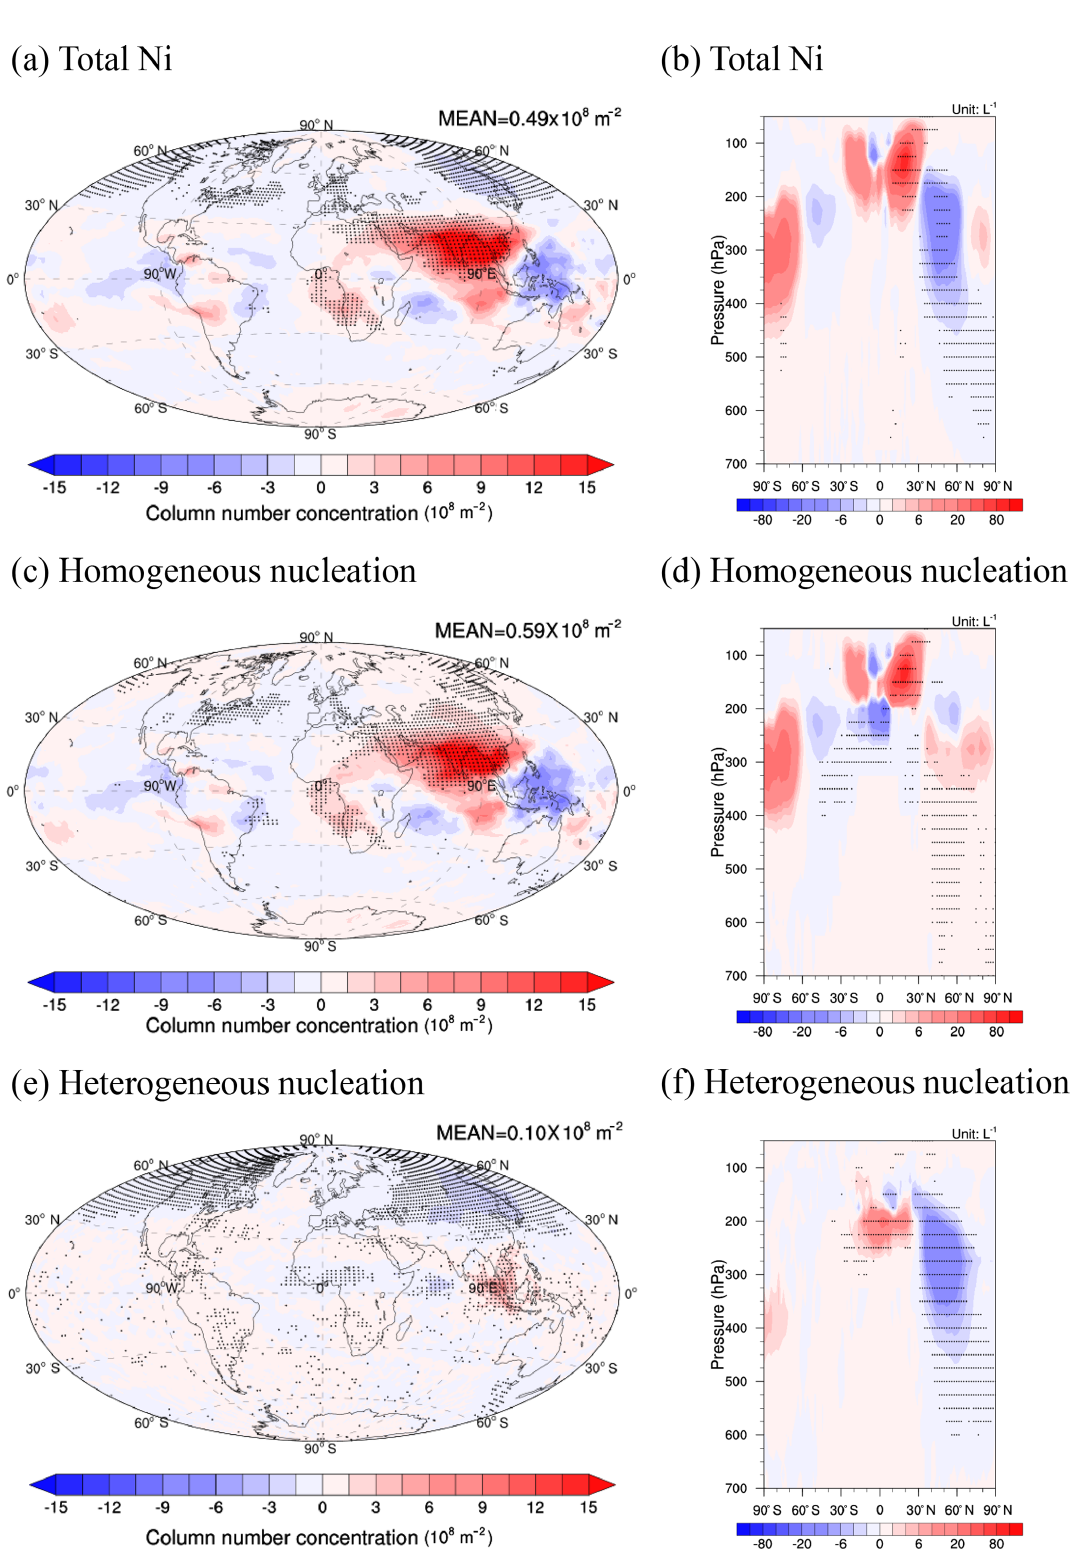
Figure 5. As in Fig. 3 but for the difference between the PD_Base and PI_ALL cases. Differences significant at the 90% level according to a Student’s t test are depicted by